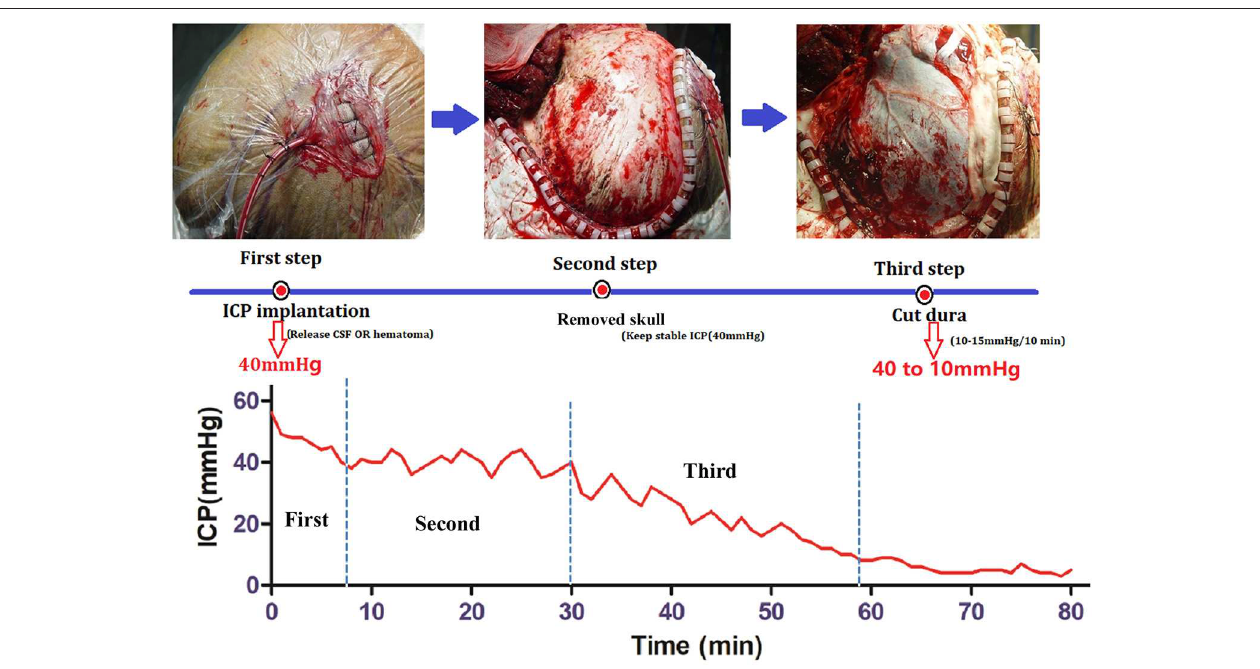
FIGURE 2 | Procedure for controlled decompression and ICP monitoring. First step: ICP probe implantation. If the ICP was higher than 40 mmHg, then CSF was released under ventricular ICP monitoring until the ICP was 40 mmHg. Second step: Skull removal. Craniotomy was performed with a bone window 12 × 15cm in size, and the ICP was maintained at 40 mmHg. Third Step: Dural incision and hematoma removal. The dura was opened with an incision that was generally no larger than 5mm, and the hematoma and brain contusion tissue were slowly aspirated, gradually reducing the